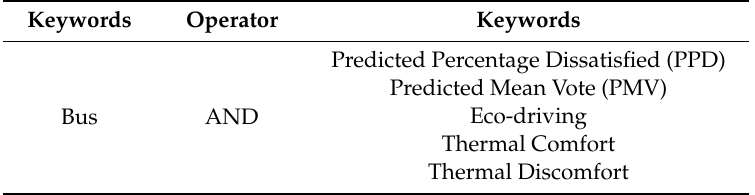
Table 1. Keywords employed in the identification stage of the method adopted. Operator